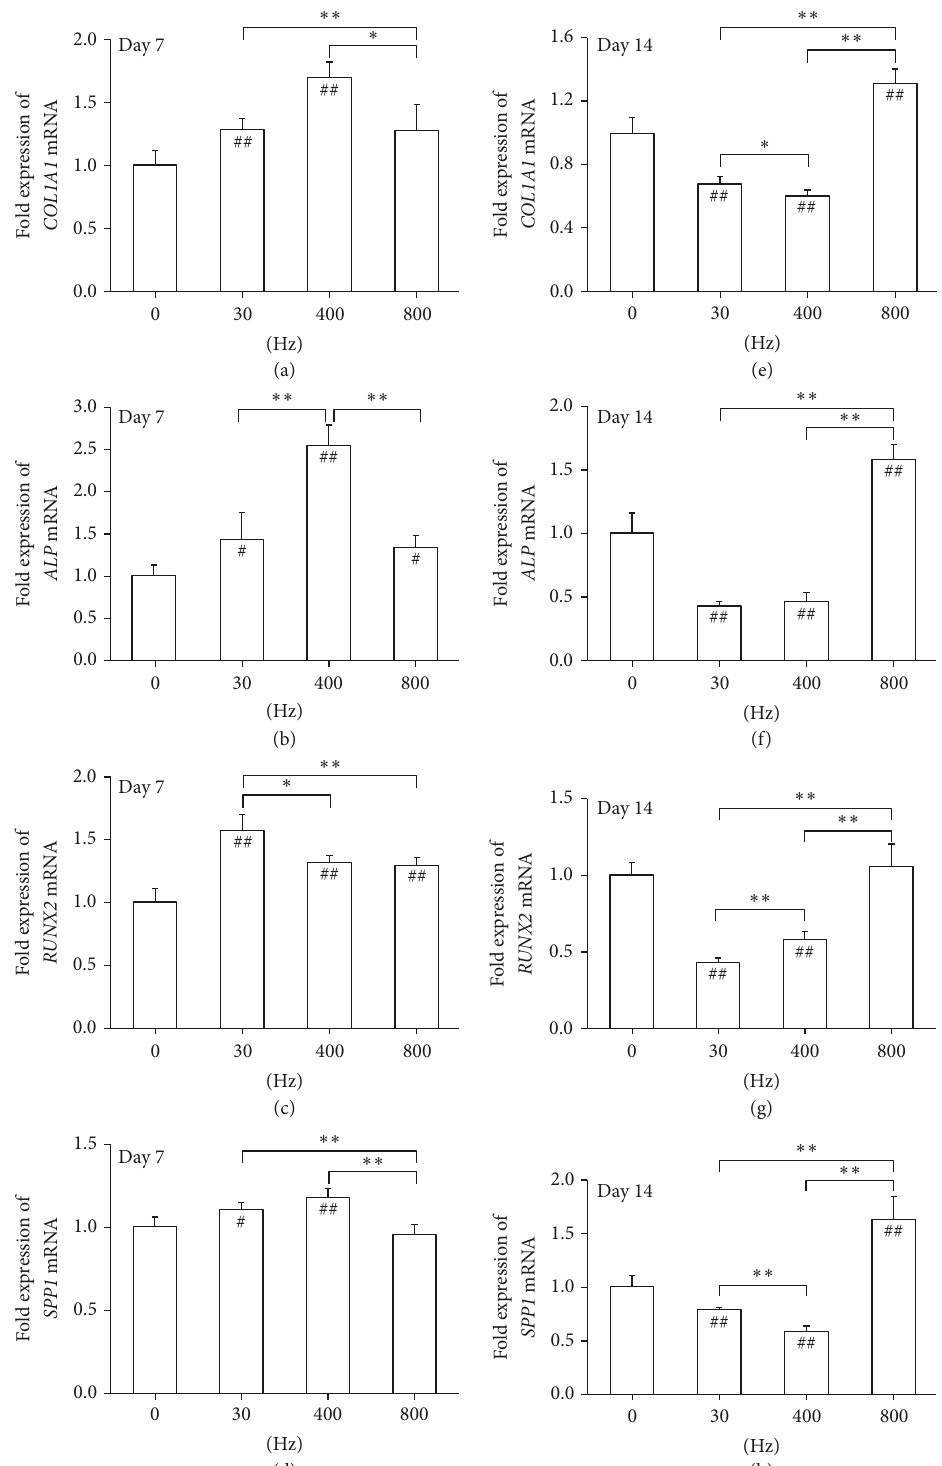
Figure 2: Acoustic-frequency vibratory stimulation (AFVS) modulates expression of mRNA encoding osteogenesis-specific markers in human bone marrow-derived mesenchymal stem cells (BM-MSCs) at the time points of day 7 ((a), (b), (c), and (d)) and day 14 ((e), (f), (g), and (h)). The mRNA levels of COL1A1 ((a), (e)), ALP ((b), (f)), RUNX2 ((c), (g)), and SPP1 ((d), (h)) were measured by real-time RT- PCR. Values are mean ± standard error of four independent experiments ( 𝑛 = 4 ). ∗ 𝑃 < 0.05 ; ∗∗ 𝑃 < 0.01 in the indicated groups from unpaired t -test. # 𝑃 < 0.01 ; ## 𝑃 < 0.01 compared with the 0Hz control group from unpaired t -test. From Chen et al. [10], CC BY